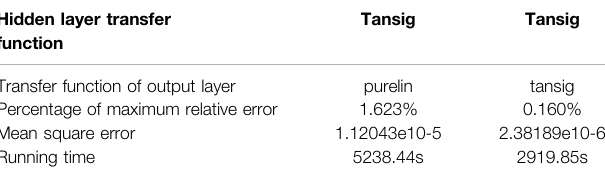
TABLE 3 | Prediction error of BPNN with different activation